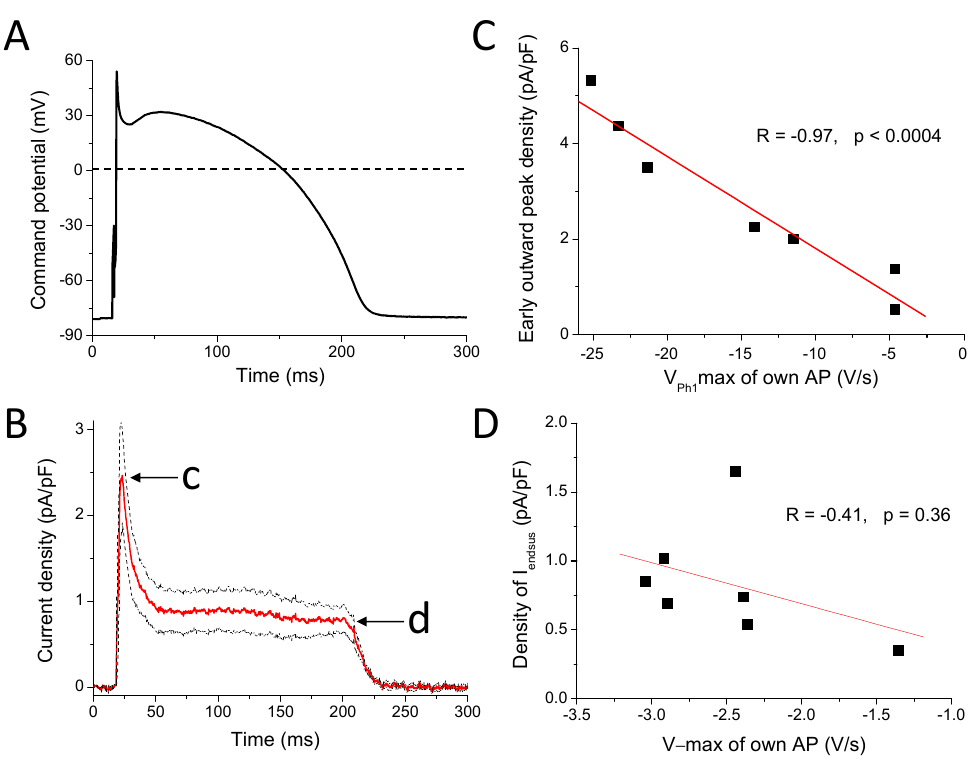
Figure 6. ABT-333-sensitive current in APVC condition. ( A ) The canonical action potential, which was used as stimulus command. ( B ) Average (red trace) ± SEM (black dotted lines) of 10 µ M ABT- 333-sensitive current. c marks the early outward peak, while d indicates the end of the sustained outward current (I endsus ). ( C ) Correlation of early outward peak current density values (indicated with c on panel B) with V Ph1 max of the own APs. ( D ) Relationship between density of I endsus values (indicated with d on panel B) and V − max values of the own APs.